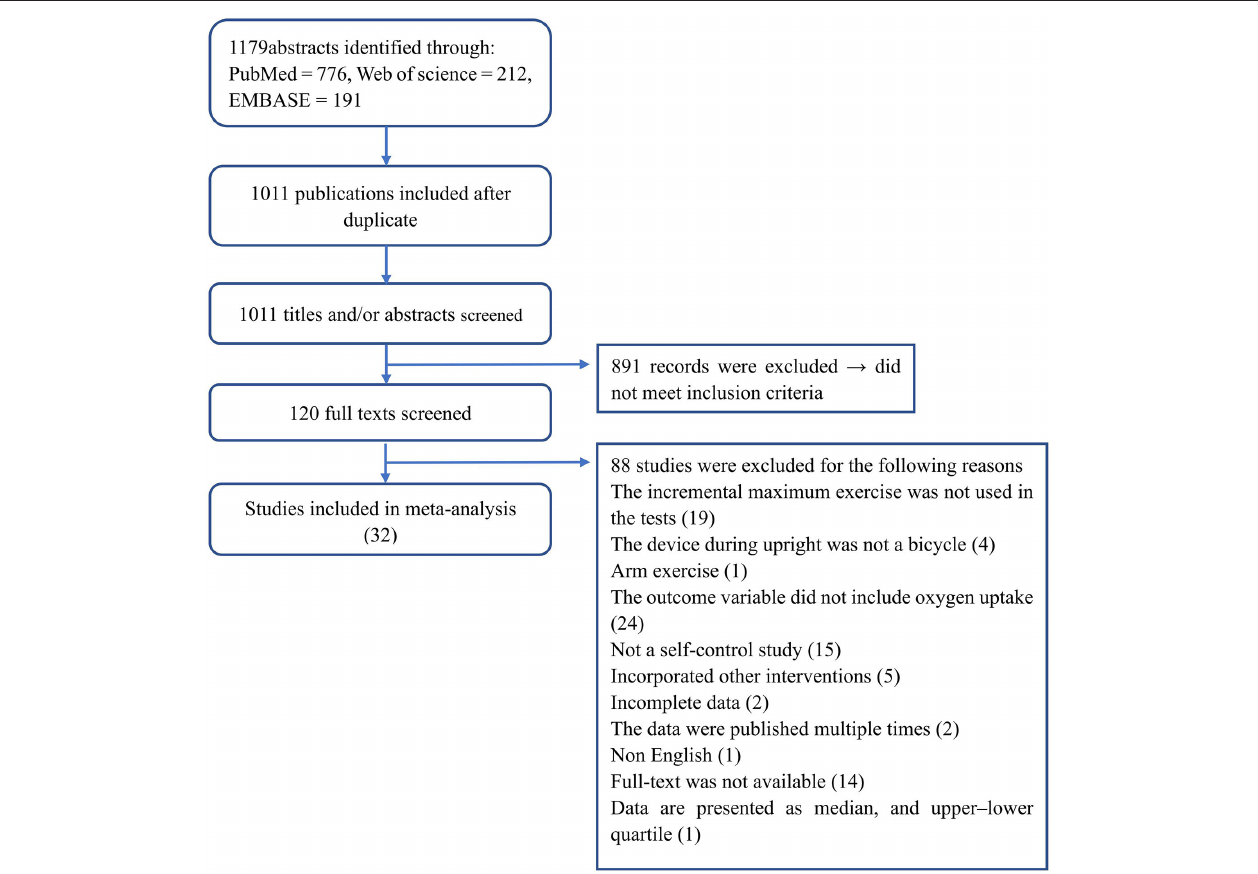
FIGURE 1 | Detailed literature search and study selection process.